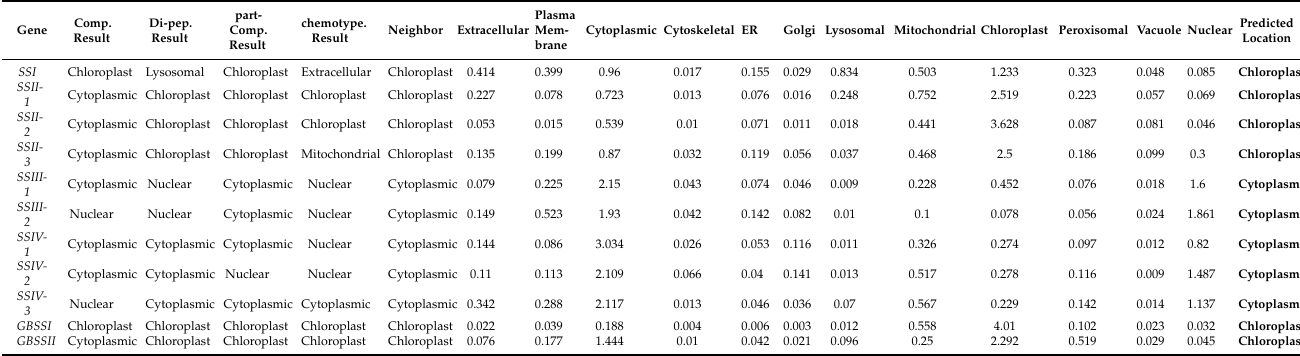
PI: Isoelectric point. MW: Molecular weight. Table 2. Prediction of subcellular localization in the starch synthase gene